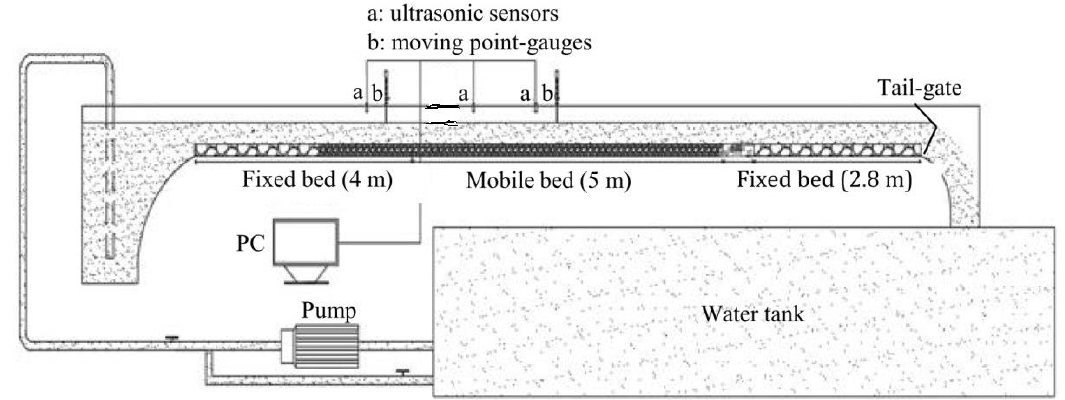
Figure 1. Experimental flume set-up (not to scale) [29]. Table 1. Physical properties of bed sediments used in this study.